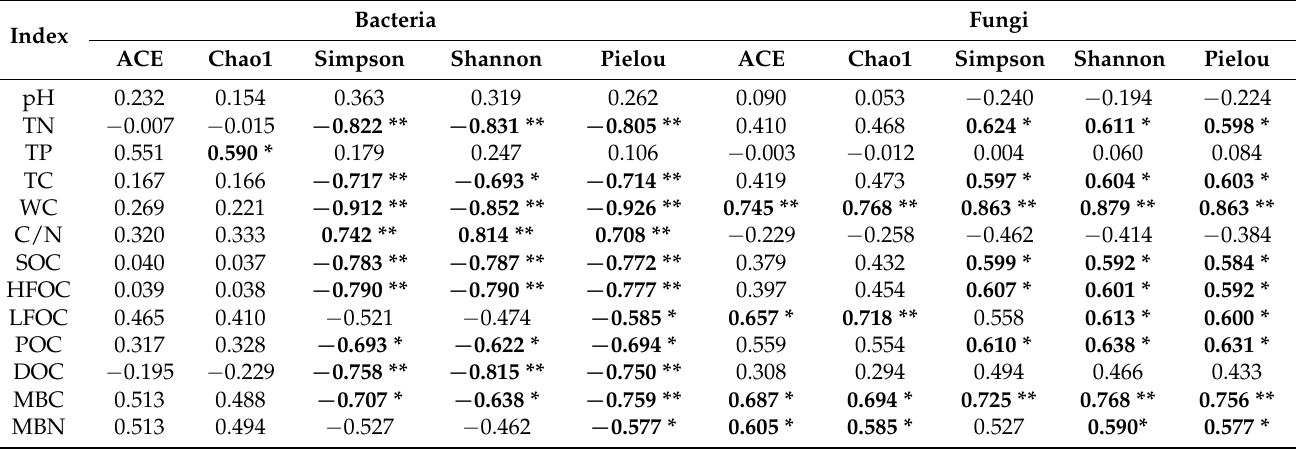
Table 4. Pearson’s correlation of microbial α -diversity index and environmental